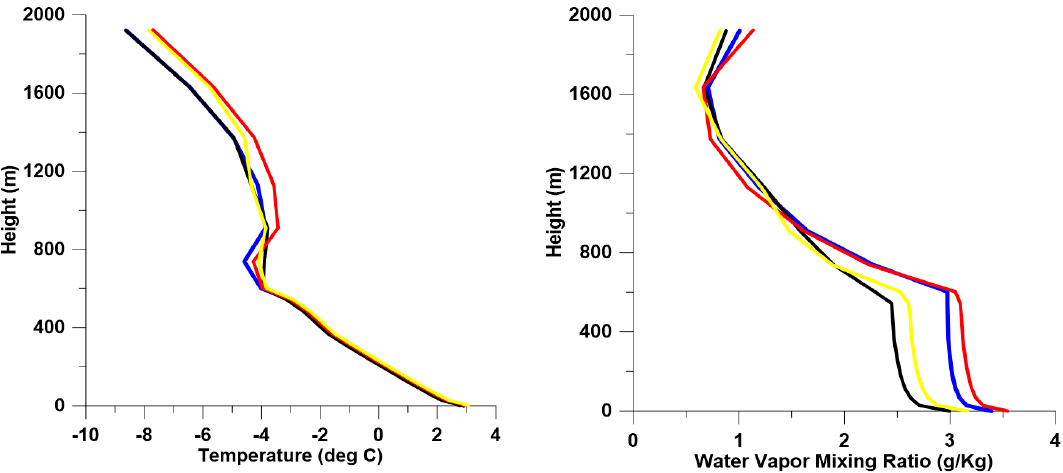
Figure 22. Polar WRF profiles of temperature ( left ) and water vapor mixing ratio ( right ) in leg 3 (red), leg 4 (yellow), leg 6 (black) and leg 7 (blue). The gradient from north to south is also clearly seen.